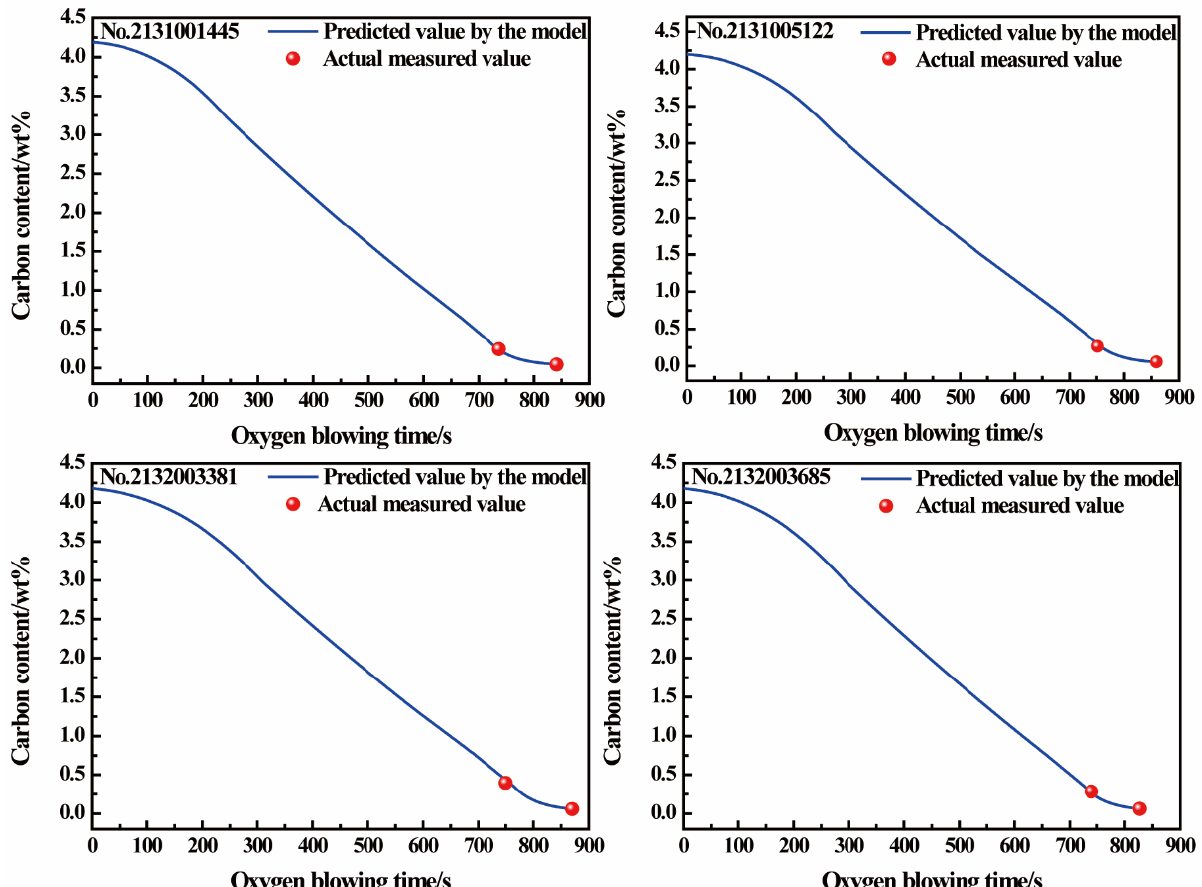
Figure 6. Comparison between predicted carbon content and actual measurement values.